Question: What type of chart is this?
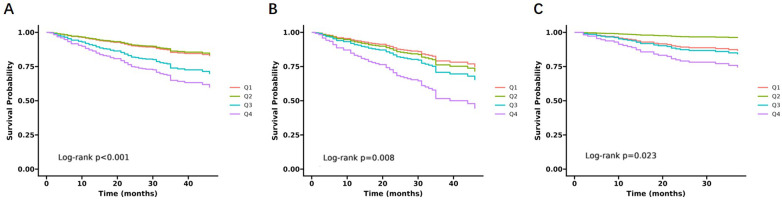
Answer: survival